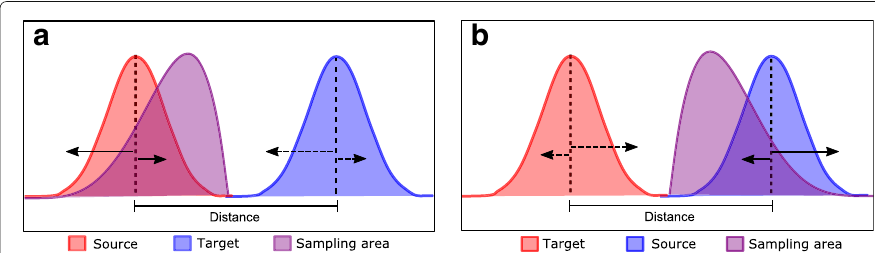
Fig. 3 Sampling of switching politicians based on ideological distance following a Beta Distribution B (α , β) . The parameters α and β which are proportional to the distance between the origin and destination means ( μ i , μ j see Fig. 2) are shown as vertical dashes. The longer horizontal arrows show the most likely shift in ideology. Because the model is probabilistic, there is also a possibility of the shift occurring in the opposite direction (shorter arrows). Continuous horizontal arrows represent the shift in the origin party while dashed arrows represent the shift in the destination party. In panel a , the destination party is on the right, hence the politicians on the right side of the origin distribution are more likely to leave. Conversely, in panel b the destination party is on the left, hence the politicians on the left side of the origin distribution are more